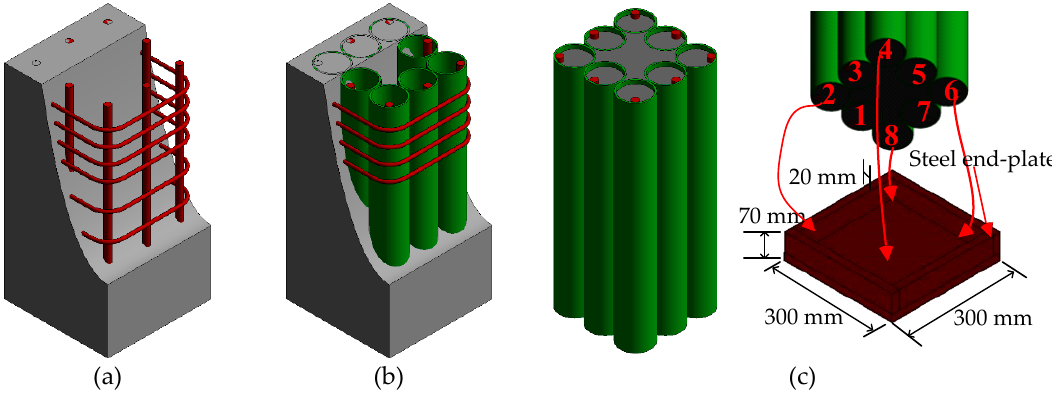
Figure 1. The constructions of all columns. ( a ) specimen T0; ( b ) specimen T8 and ( c ) specimen T8N.